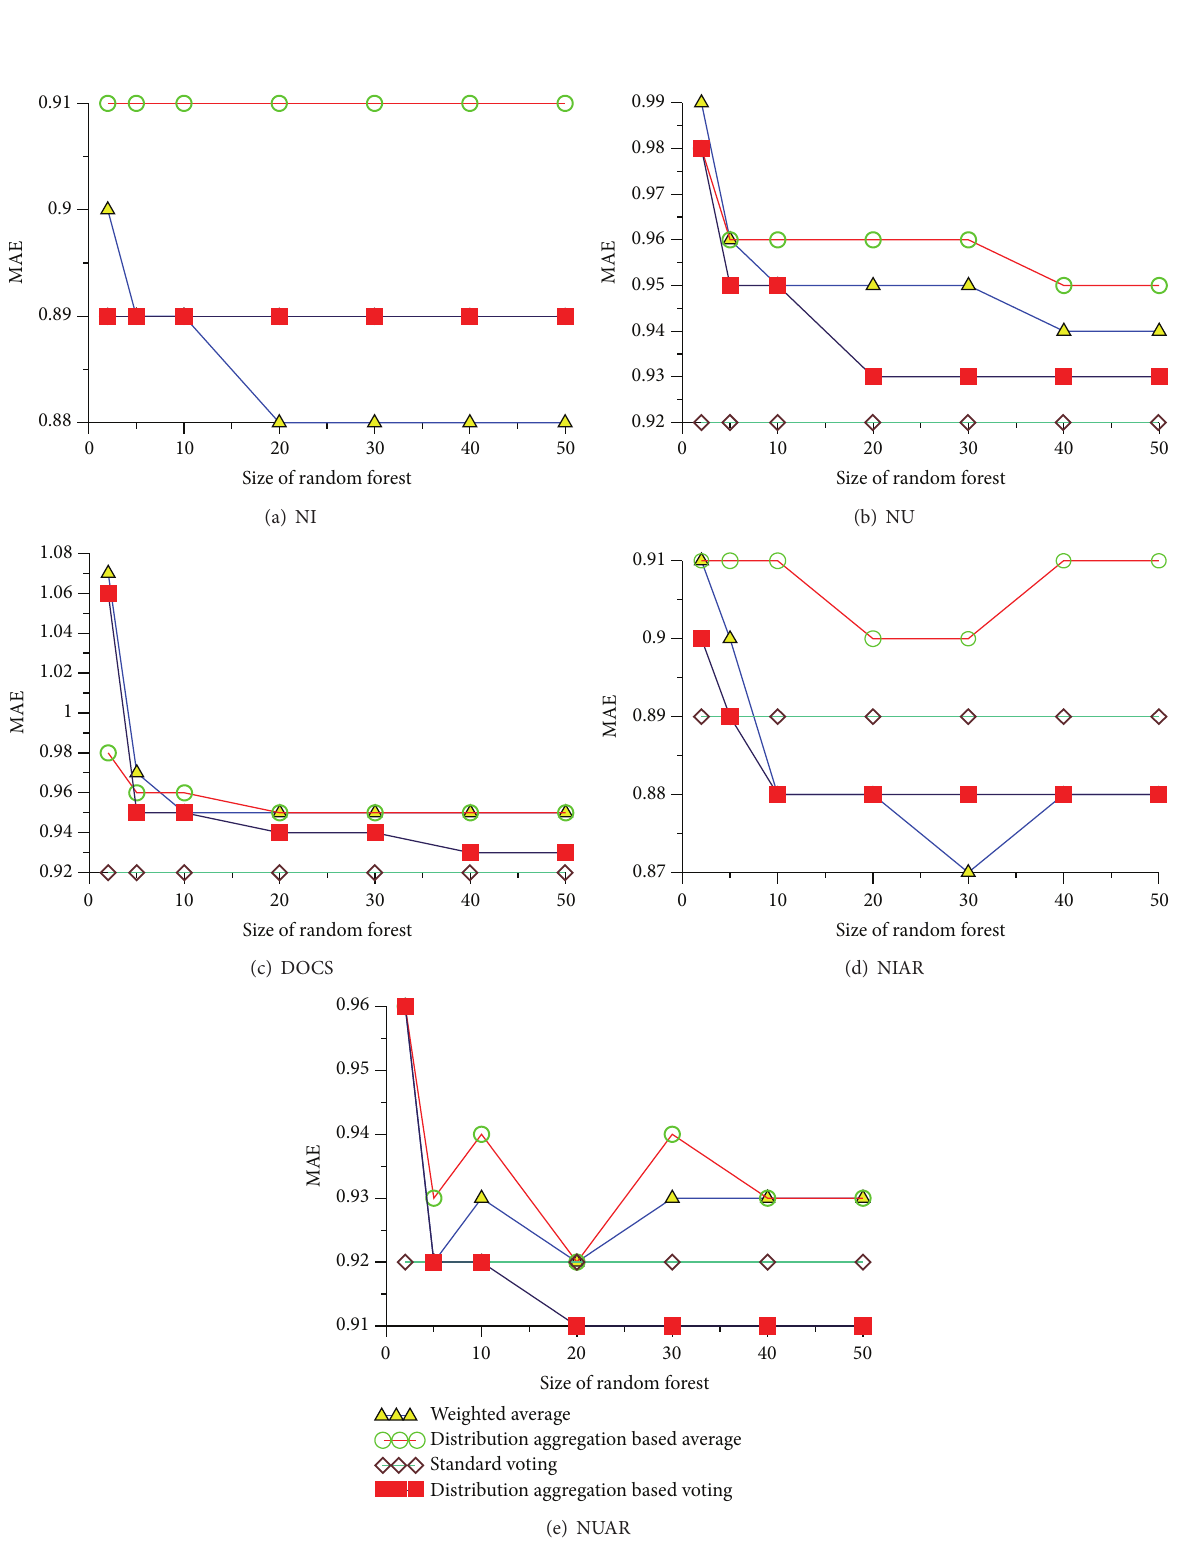
Figure 4: Comparisons of different prediction